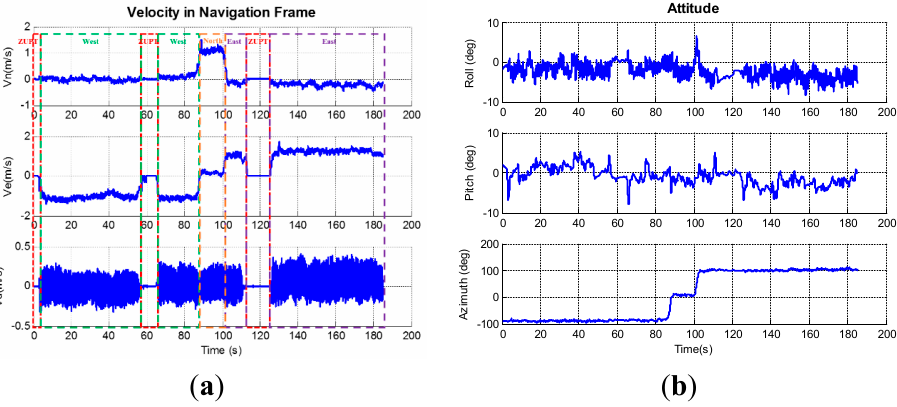
Figure 5. The solution of the proposed PDR/INS integrated MEMS solution. ( a ) Velocity; ( b ) Attitude.